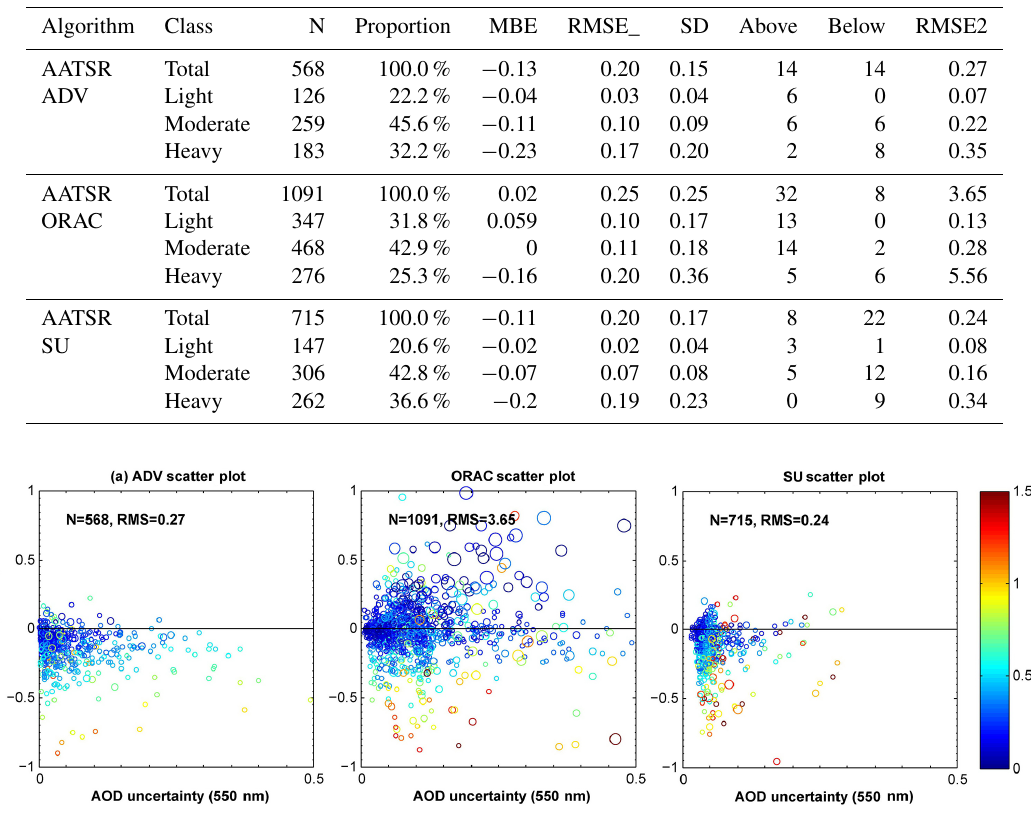
Figure 4. Scatter plots of ADV, ORAC, and SU AOD uncertainty with AOD bias over China for the 3 years of 2007, 2008, and 2010. The area and colours of bubbles represent Std_S and AOD,